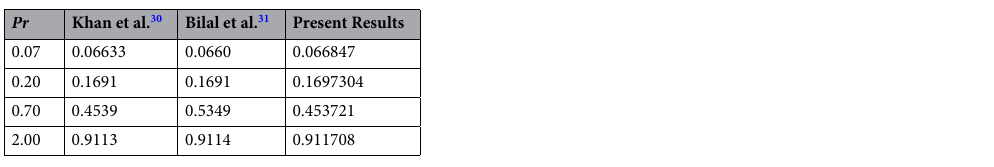
Table 3. Computation of heat temperature rate for ( g = 0 ; i.e. two diemsional case) against Prandtl number by fixing other